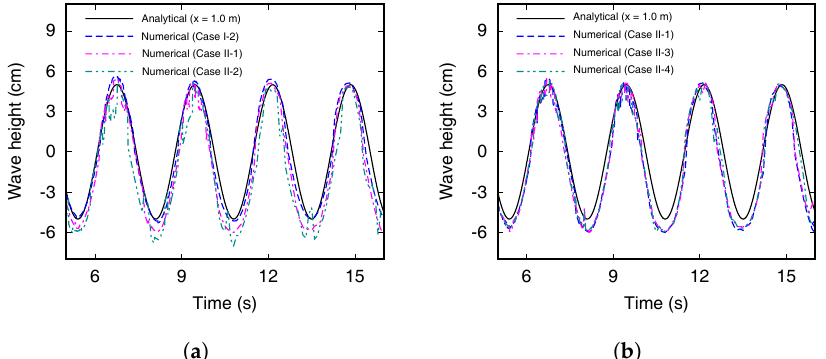
Figure 6. Comparison of the numerical wave height with different the ( a ) initial particle spacings and ( b ) time